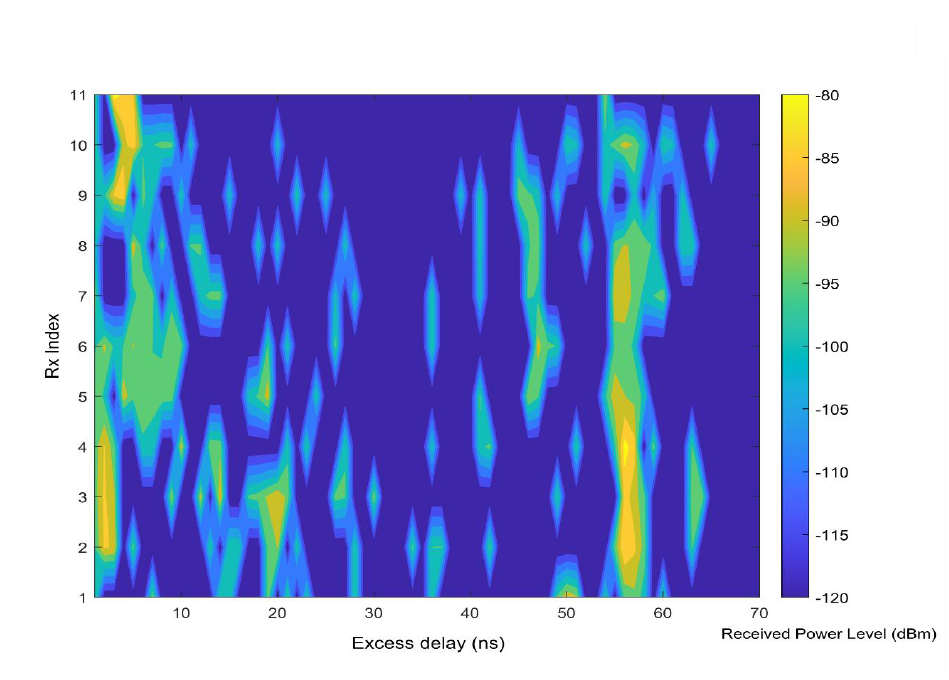
Figure 4. Received power level versus excess delay at all of the receiver sites.